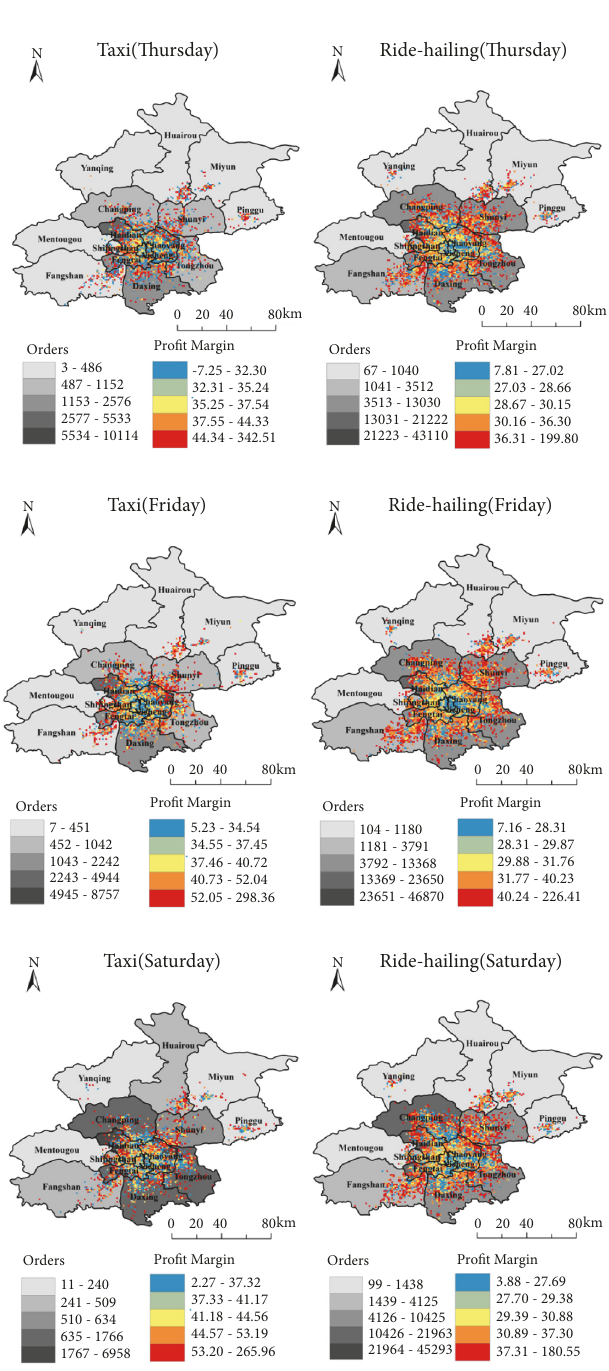
Figure 1: The pick-up points of taxis and ride-hailing on Thursday, Friday, and Saturday, respectively. The orders in the legend refer to the service order counts interval in different administrative districts. The background color depth of each administrative district in Beijing is proportional to the number of orders. The red areas are defined as the HQC points in this